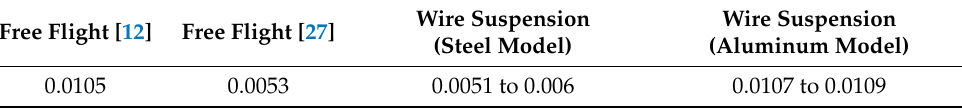
Table 3. Non-dimensional frequency k of the Basic Finner for free-flight and wind-tunnel tests at Mach